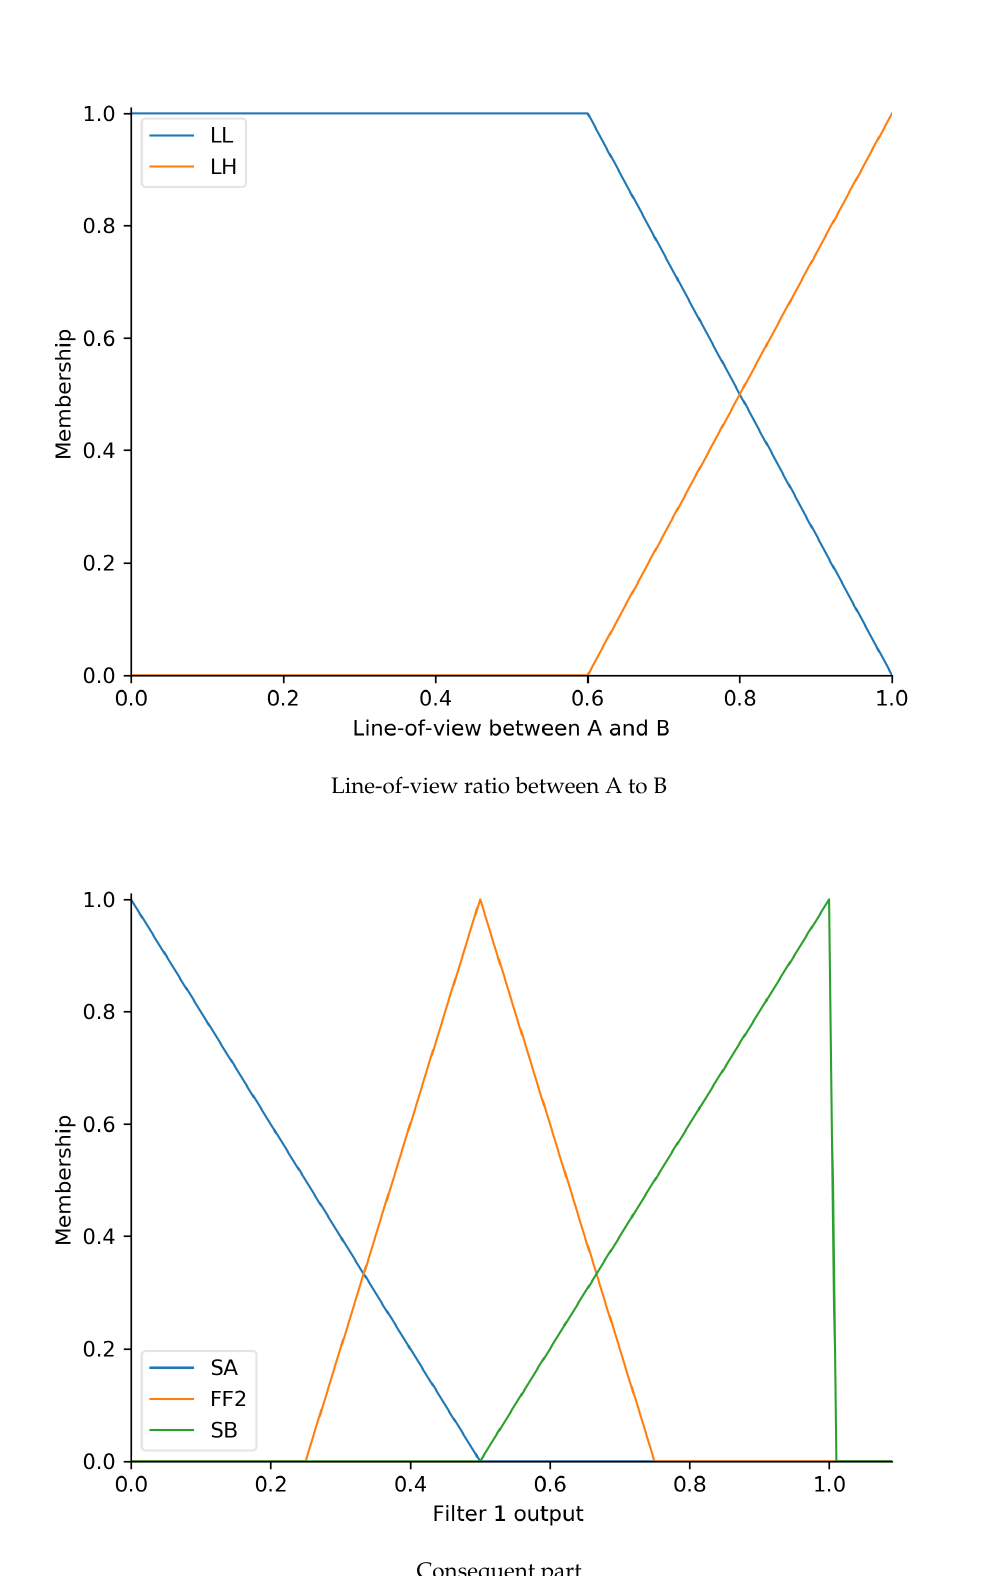
Figure 7. Membership functions for antecedent and consequent parts in FNFA. Some of the plots are expressed in logarithmic scale due the extension of Universe of